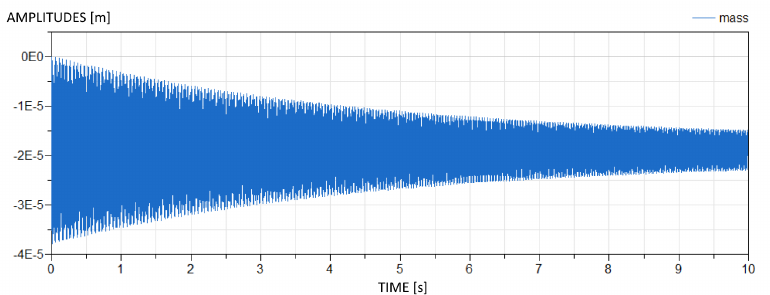
Figure 13. Mass amplitudes of the simple mass–spring coupled with play ( f r = 250